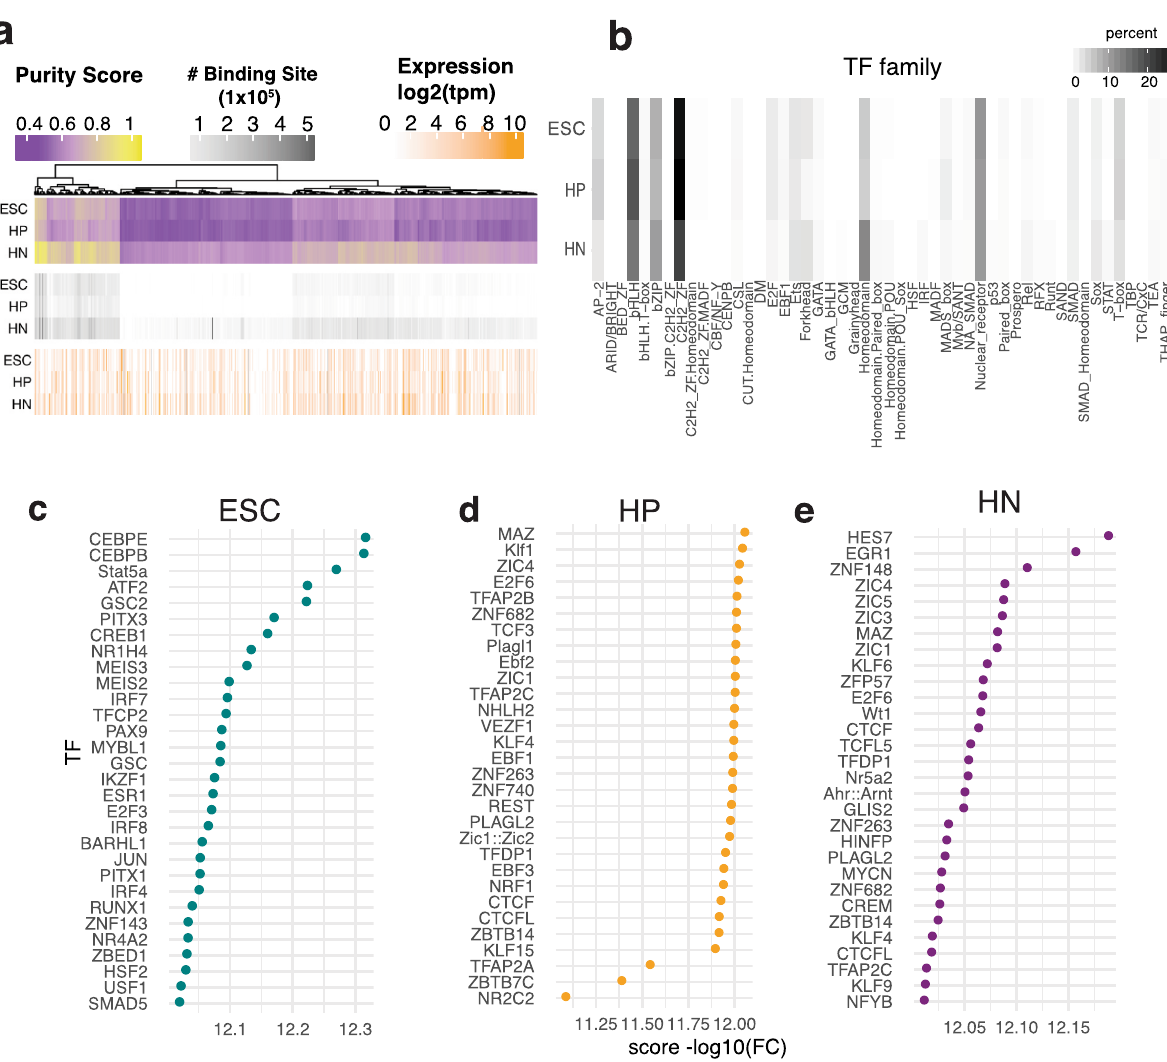
Fig. 3 TF footprinting and analysis. a The summary of TF-binding site prediction, the Purity scores calculated by PIQ (purple/yellow), the number of TF- binding sites passing purity cutoff >0.7 thresholds (Grayscale), log 2 transformed expression of the respective TF in HN (white/orange). b Grouping number of TF-binding sites family. Darker color indicates a higher number of predicted binding sites. c – e Enrichment of TF-binding sites in putative cREs compared to other OCRs in each cell type adjusted for GC content and